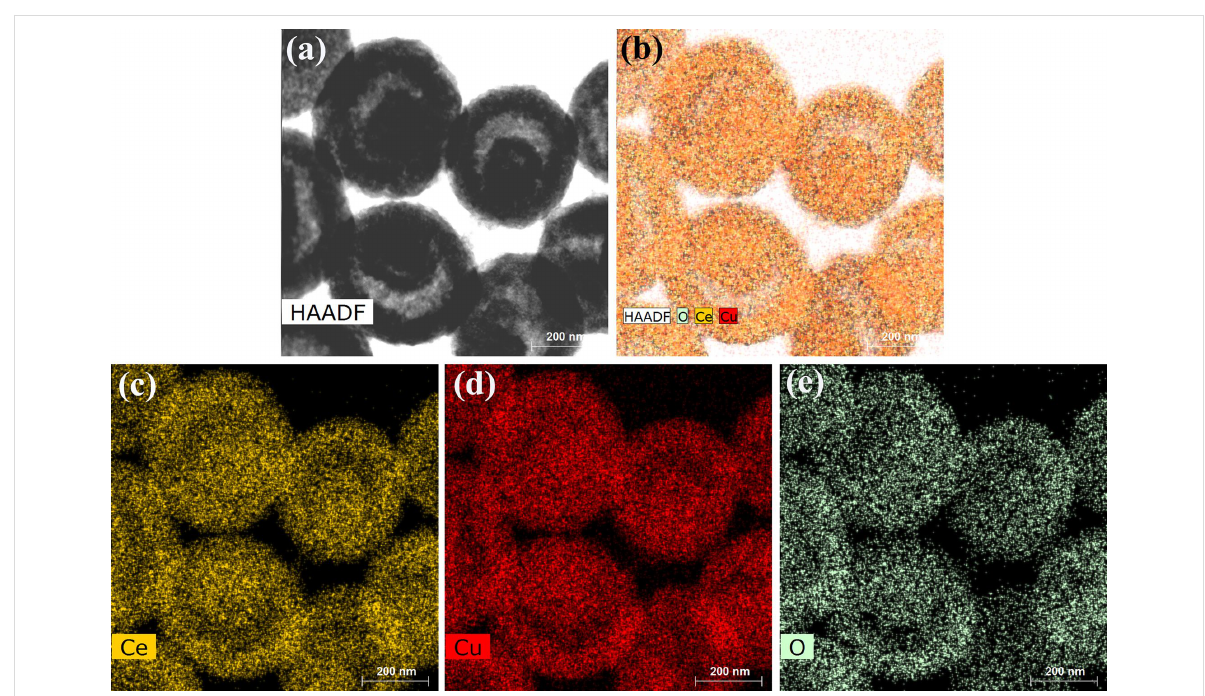
Figure 4: TEM image (a) and its mapping analysis (b–e) of the CeO 2 –CuO x composite yolk–shell nanospheres.